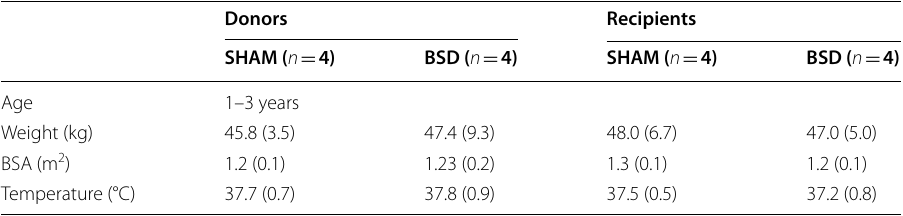
All data are expressed as mean (standard deviation). BSA body surface